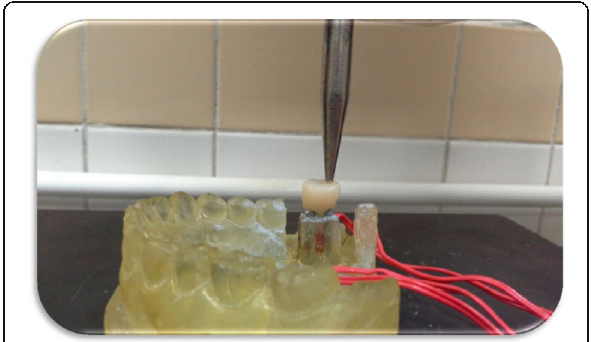
Fig. 6 Loading of implant